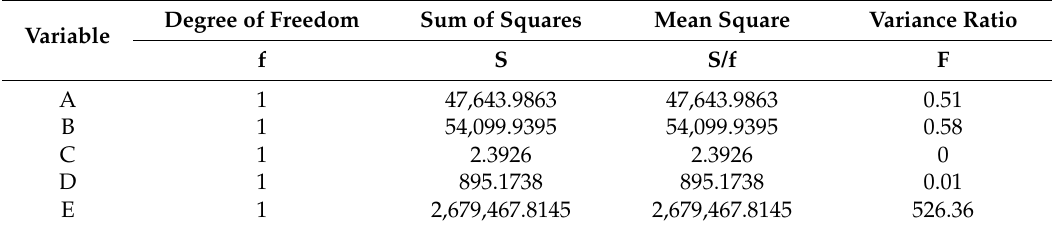
Table 10. Analysis of Variance (ANOVA) of results from first round of simulation runs.